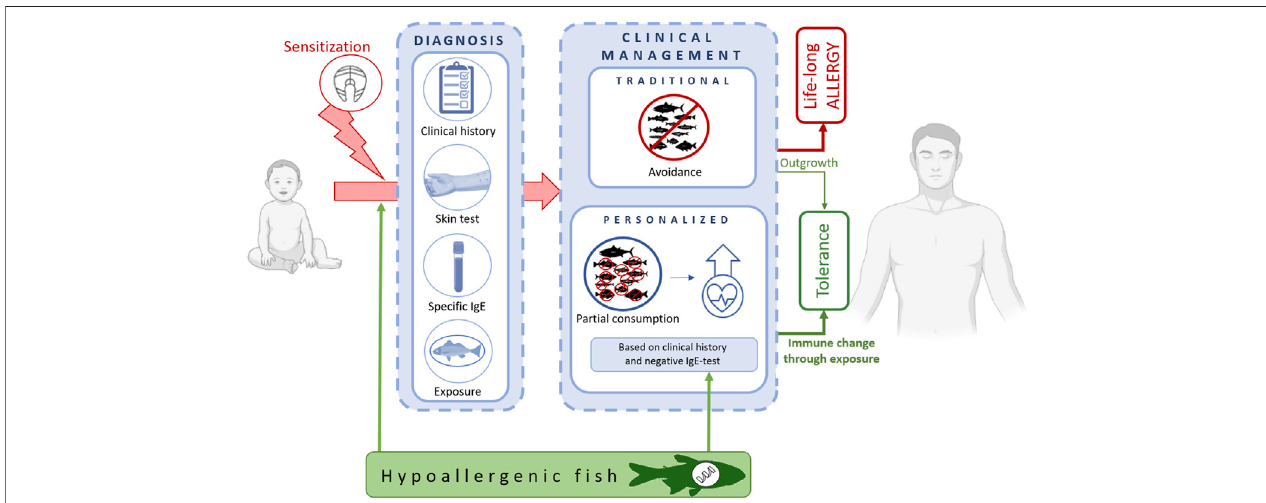
FIGURE 2 | Fish diet supplementation strategy used in gilthead seabream ( Sparus aurata ) and European seabass ( Dicentrarchus labrax ) allergenicity modulation studies. Both species were fed for 3 months, in separate trials, using diets supplemented with different incorporation percentages of EDTA and creatine. EDTA- supplemented diets aimed at inducing the apo-form of the major fi sh allergen parvalbumin, a calcium-devoid conformation of this protein reported to be less immunoreactive, while the diets supplemented with creatine targeted parvalbumin ’ s abundance.